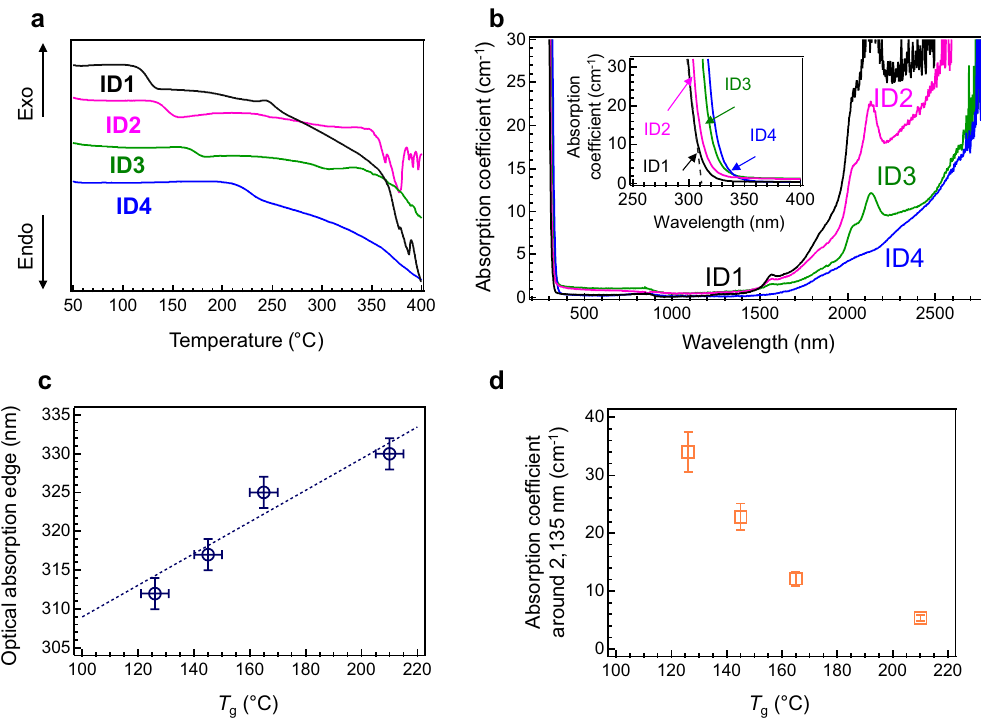
Figure 1. Thermal and optical properties of SnO–P 2 O 5 -based glasses: ( a ) DTA curves of the SnO–P 2 O 5 -based glasses listed in Table 1. ( b ) Optical absorption spectra of 50SnO–50P 2 O 5 (ID1), 55.6SnO–44.4P 2 O 5 (ID2), 60SnO–40P 2 O 5 (ID3), and 10K 2 O–50SnO-40P 2 O 5 (ID4) glasses melted at 500 °C for 30 min. Inset shows the expanded spectra at the optical absorption edge region. The dashed line indicates the ID1 extrapolation line for the optical absorption edge. ( c ) Relationship between the optical absorption edge and T g of these glasses. ( d ) Relationship between absorption coefficient at approximately 2,135 nm and T g